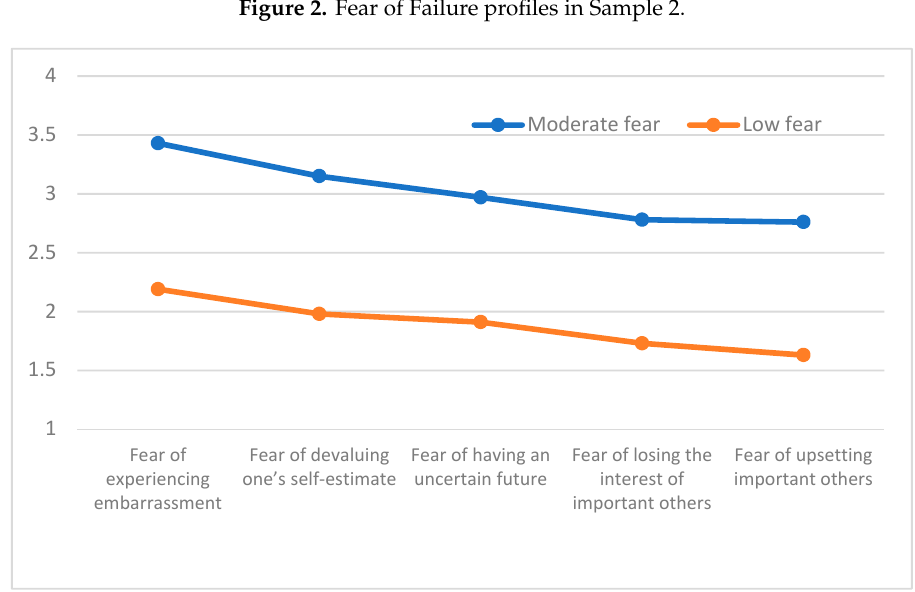
Figure 3. Fear of Failure profile in overall sample.